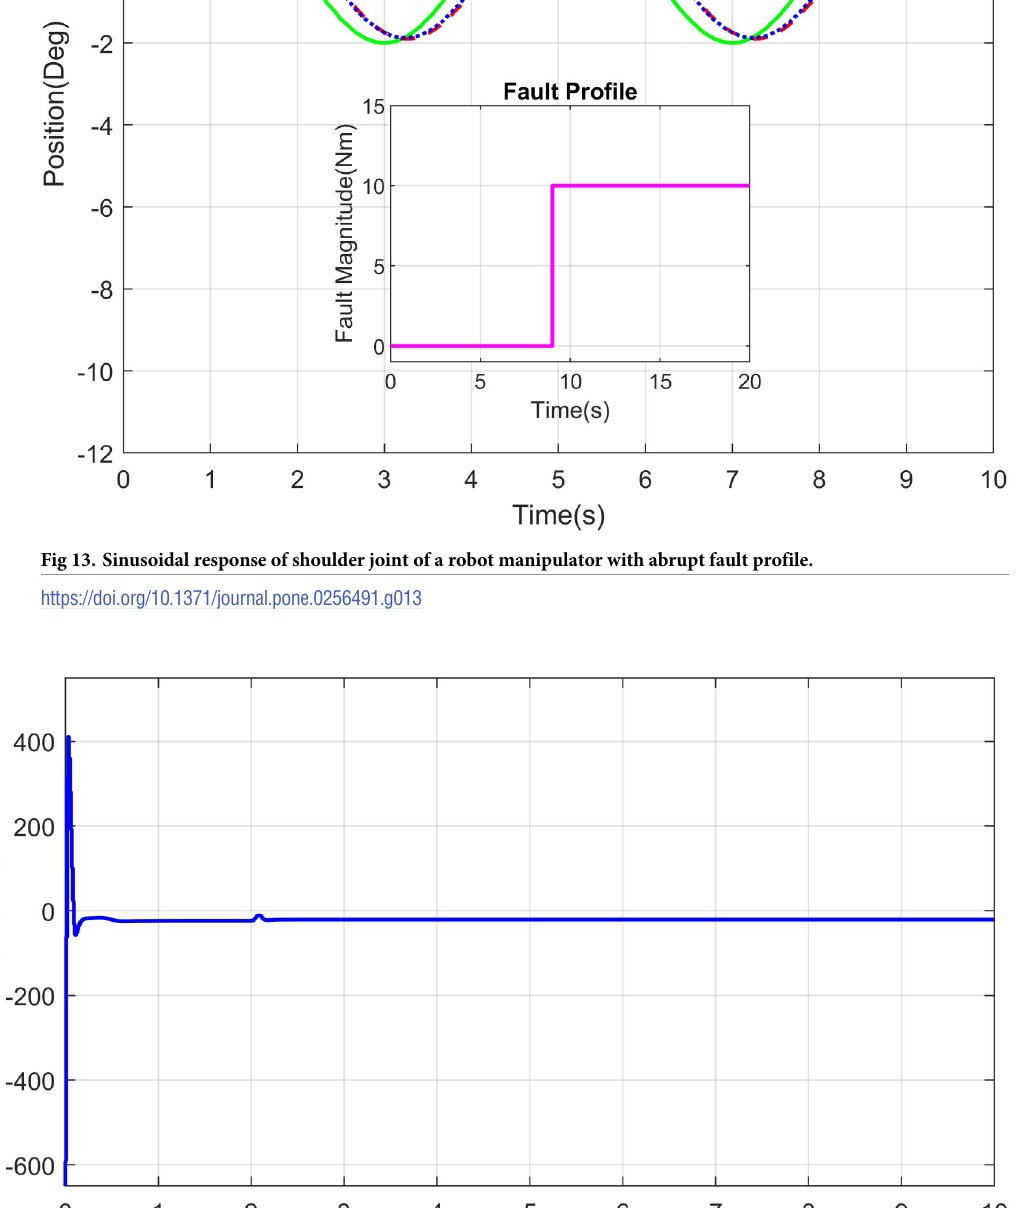
PLOS ONE | https://doi.org/10.1371/journal.pone.0256491 August 20,